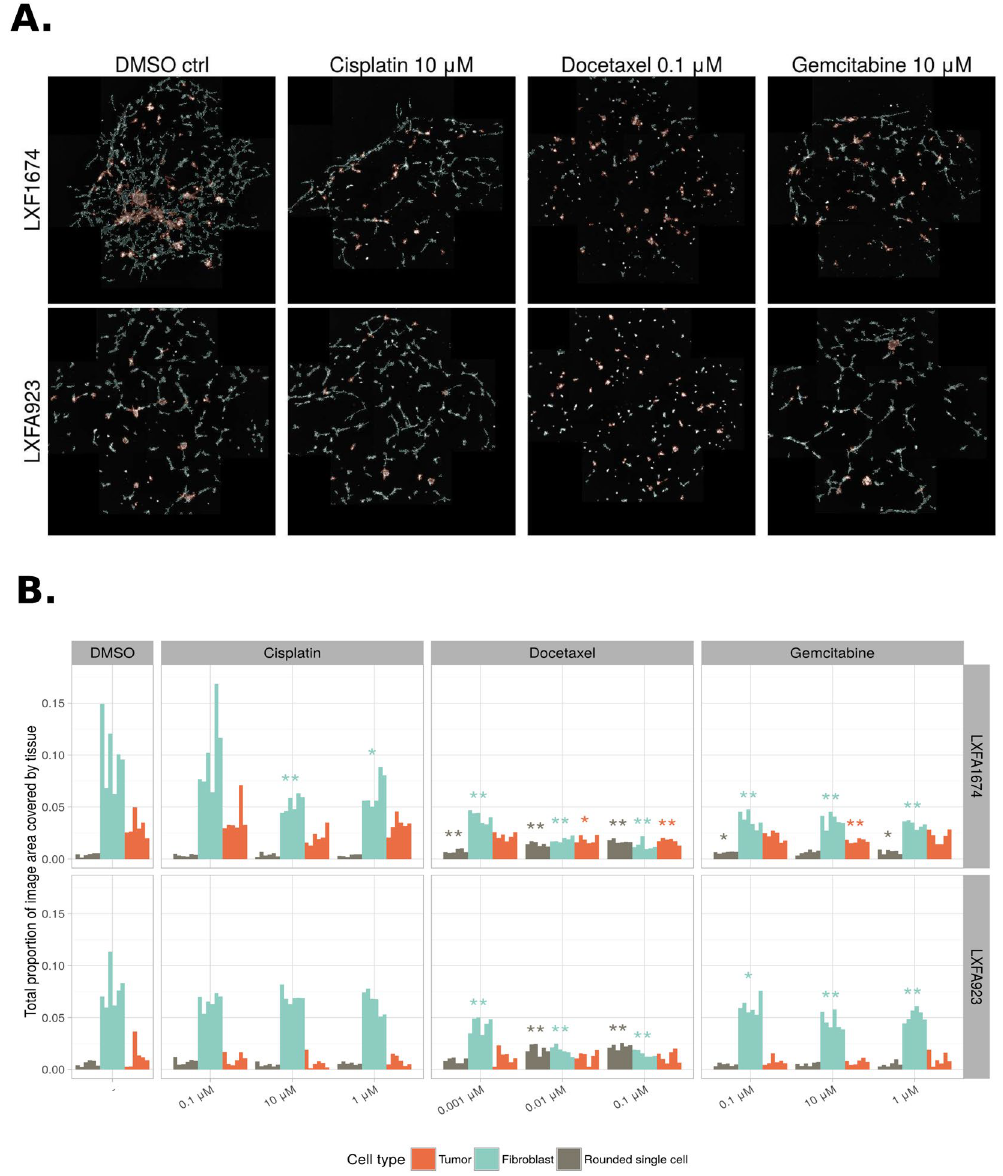
Figure 7. Segmentation and quantification of drug responses in PDX microtissues. ( A ) Examples of original segmented images from two patient samples (LXFA 1647 and LXFA 923) treated with standard-of-care drugs, cisplatin, docetaxel and gemcitabine. Only example segmented images of the highest drug concentrations are shown. Different cell types are depicted by distinct colors. ( B ) The estimated area covered by the three cell types: tumor, fibroblast and rounded single cells. The data are based on the estimates given by the proposed segmentation sequence. Each bar corresponds to one well. The stars denote the p-value of the robust Van den Waerden test 63 against the DMSO control: * p < 0.05, ** p < 0.01, *** p <